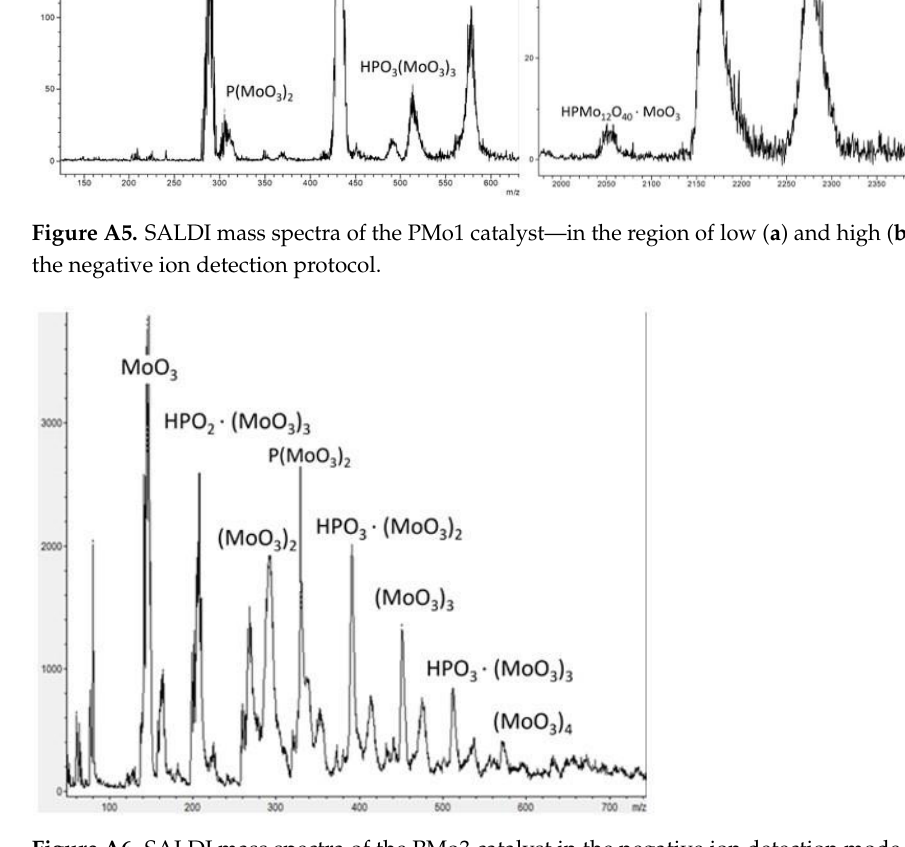
Figure A6. SALDI mass spectra of the PMo3 catalyst in the negative ion detection mode.